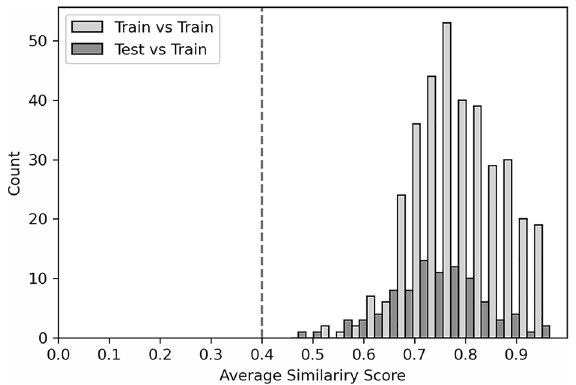
Figure 4. Histograms of average similarity scores of training and test sets. The average similarity score is derived by averaging the Tanimoto similarity score between the five most similar compounds in the training set. The light grey histogram represents the distribution of the average similarity scores for all the compounds composing the training set, whereas the dark grey histogram the distribution for the test set. The lower limit of the above-mentioned distributions allows for determining the similarity threshold of the applicability